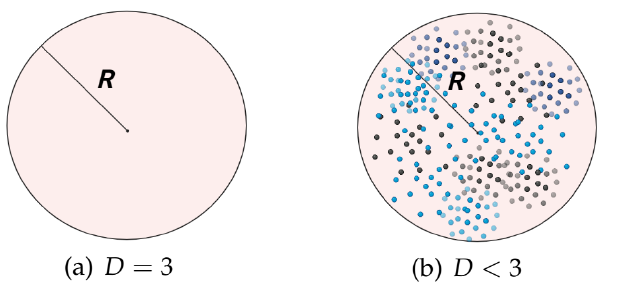
Figure 2. Schematic of a ball region of a fluid with radius R : ( a ) viscous fluid; ( b ) self-similar viscous